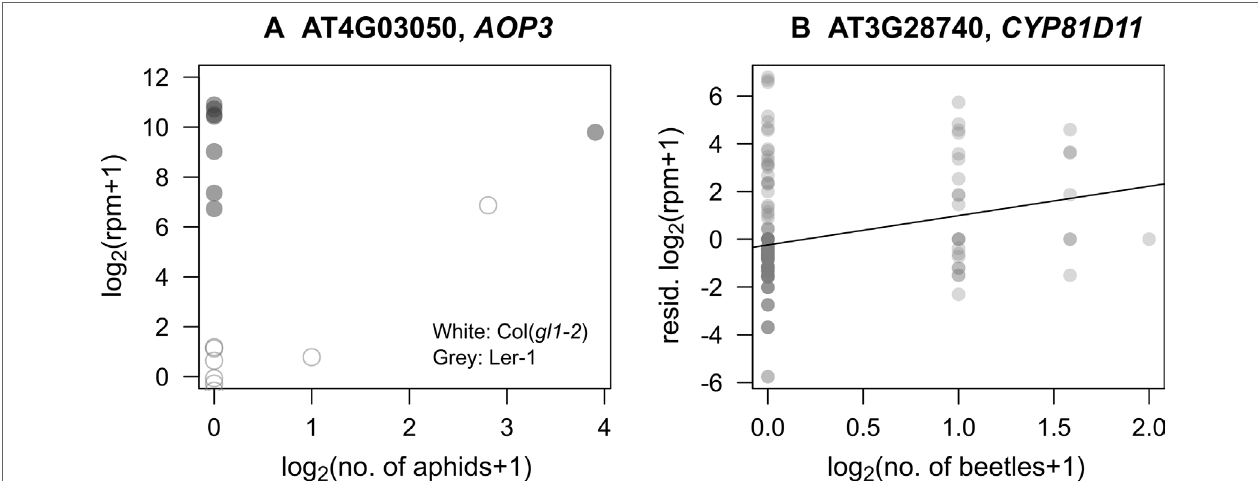
FIGURE 3 | Correlations between candidate gene expression and insect abundance in the field. (A) Relationship between the number of specialist mustard aphids ( L. erysimi ) and the expression of AOP3 in L er -1 (an accession with constitutive expression) and Col( gl1-2 ) (an accession with potentially induced expression). (B) Relationship between the number of Phyllotreta beetles and expression of CYP81D11 ; residuals unexplained by plant accessions are shown in the Y